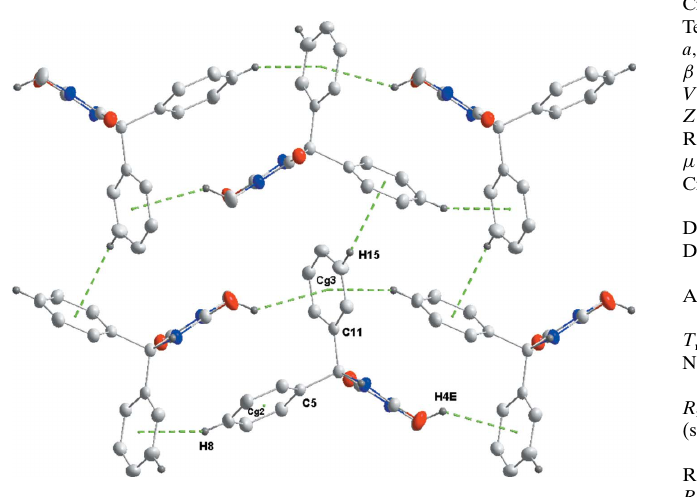
Figure 1 The title molecule with the labelling scheme and 50% probability displacement ellipsoids.